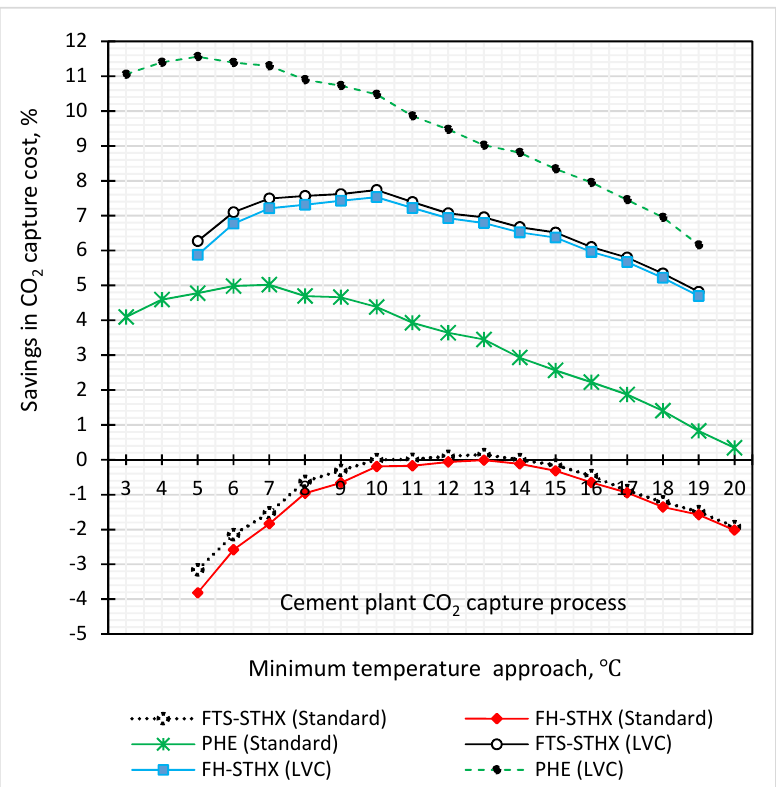
Figure 12. Cost reduction analysis at different ∆ T min for different heat exchanger types compared with FTS–STHX of ∆ T min = 10 ◦ C in the cement plant capture process. °C and 5 °C in the cases of the FTS-STHX and PHE, respectively.